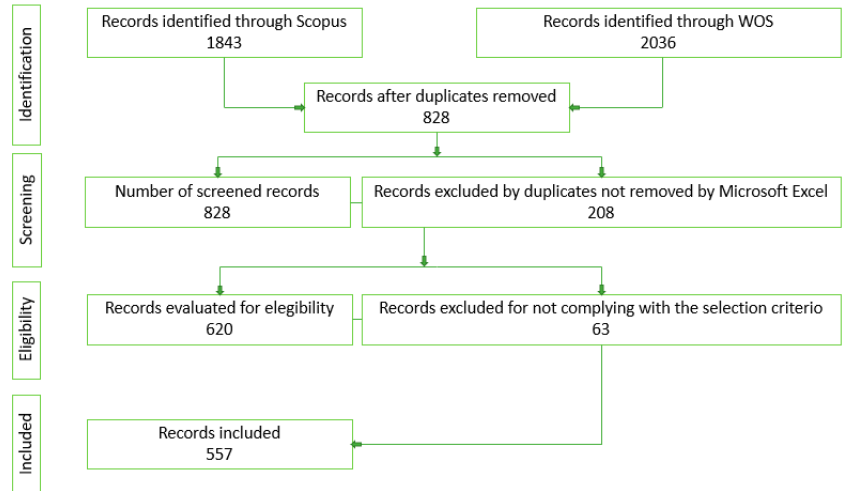
Figure 2. Publications of scientific articles—PRISMA 2020 inspired flow diagram.